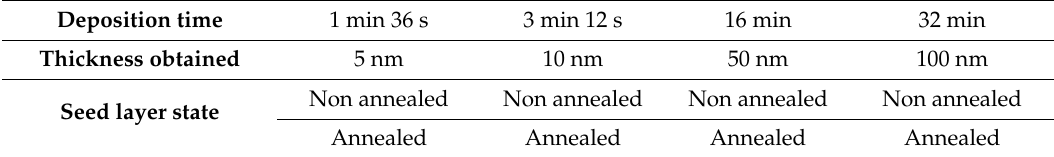
Table 1. ZnO seed layer deposition